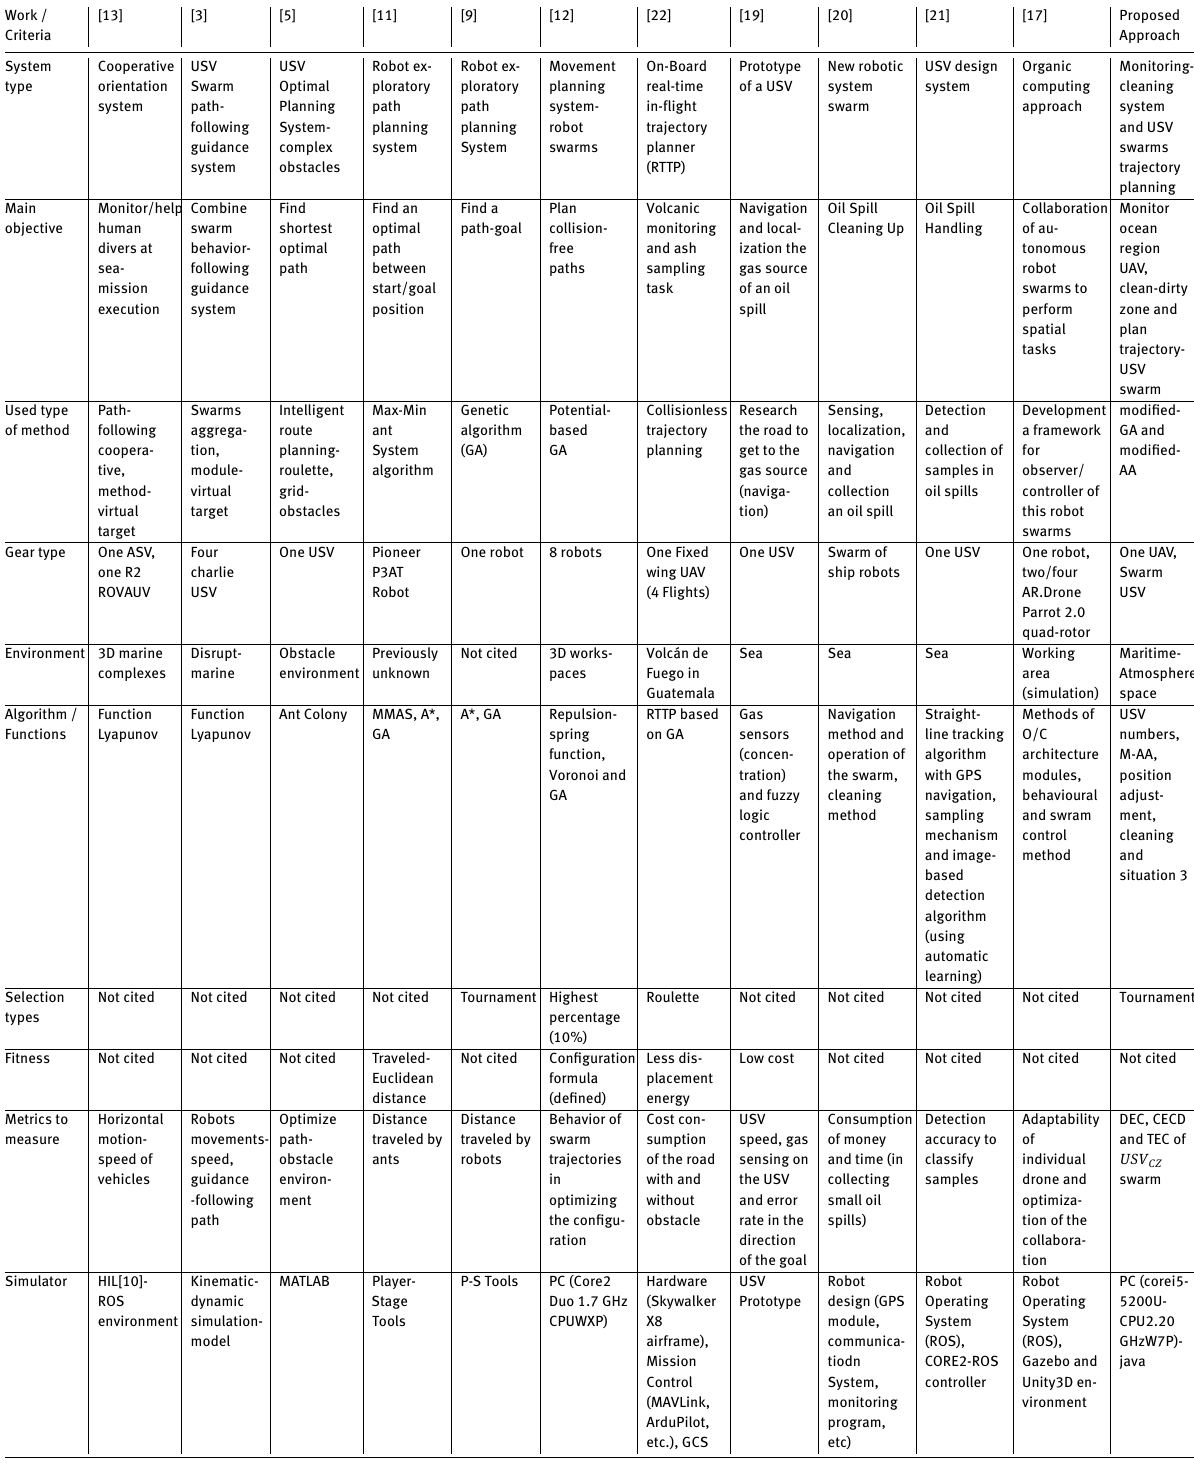
Table 4: Comparison between several related